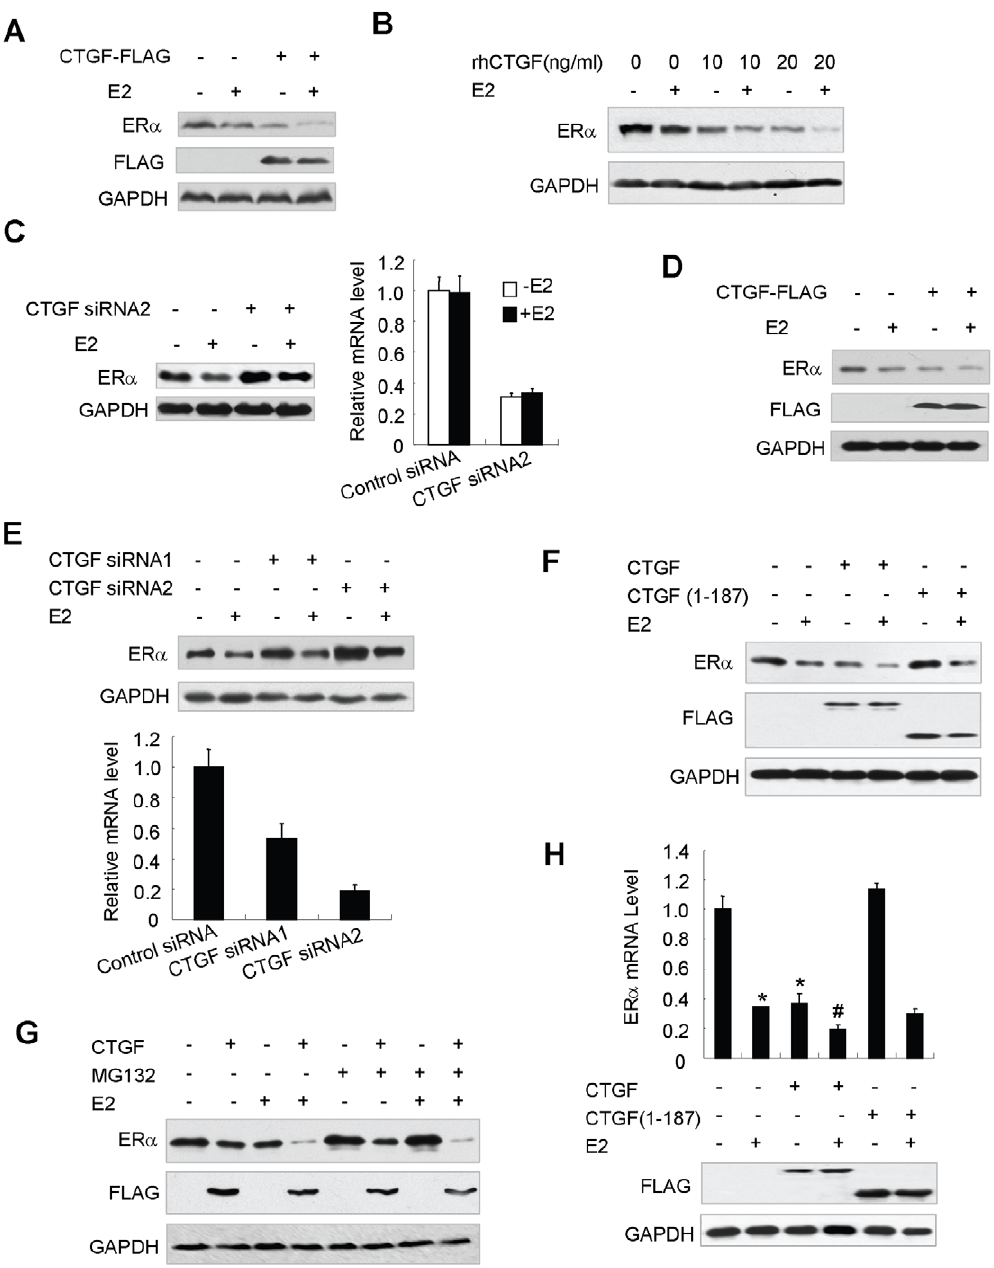
Figure 8. CTGF inhibits ER a expression. (A) MCF7 cells stably transfected with FLAG-tagged CTGF, which constitutively expressed FLAG-CTGF, or MCF7 cells stably transfected with empty vector were treated with 10 nm E2 for 24 h. Whole cell lysates were blotted with the indicated antibodies. (B) MCF7 cells were treated with the indicated amounts of recombinant human CTGF (rhCTGF) and analyzed as in (A). (C) MCF7 cells transfected with CTGF siRNA2 or control siRNA were treated and analyzed as in (A). Knockdown effect of CTGF siRNA2 on the endogenous CTGF mRNA level was determined by real-time PCR with CTGF and b -actin primers (right panel). (D) ZR75-1 cells transiently transfected with FLAG-tagged CTGF or empty vector were treated and analyzed as in (A). (E) ZR75-1 cells transfected with CTGF siRNA1 or CTGF siRNA2 were treated and analyzed as in (A). Knockdown effect of CTGF siRNA1 or CTGF siRNA2 on the endogenous CTGF mRNA levels was determined as in (C) (lower panel). (F) MCF7 cells were transfected with FLAG-tagged CTGF or CTGF(1–187) and treated with 10 nm E2. Cell lysates were analyzed by immunoblot with the indicated antibodies. (G) MCF7 cells stably transfected with FLAG-tagged CTGF or empty vector were pretreated with 10 m M MG132 for 1 h to block proteasome activity. Cells were then treated with 10 nM E2 for 24 h. Cell lysates were analyzed as in (D). (H) MCF7 cells transfected with FLAG-tagged CTGF or CTGF(1–187) were used for real-time RT-PCR with ER a and GAPDH primers (upper panel). Cell lysates were examined by immunoblot with the indicated antibodies (lower panel). Data shown are means 6 SD of triplicates of one representative experiment and have been repeated three times with similar results. * P , 0.01 versus empty vector without E2. # P , 0.01 versus empty vector with E2.